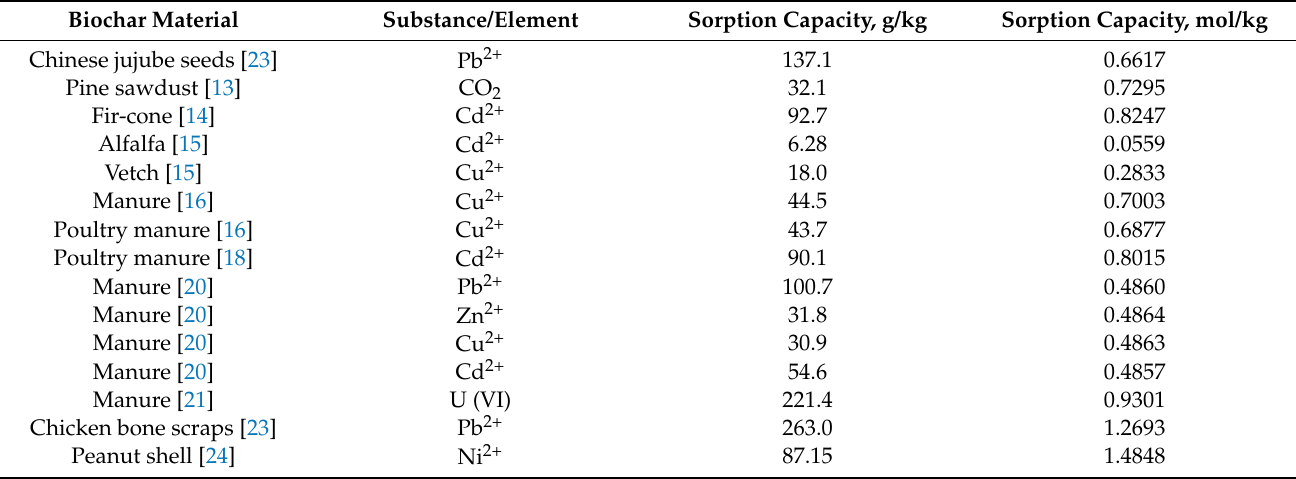
Table 1. Values of sorption capacities for metal ions and CO 2 for biochar made from waste materials. Biochar